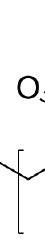
Figure 7. Chemical structure of PNIPAM.